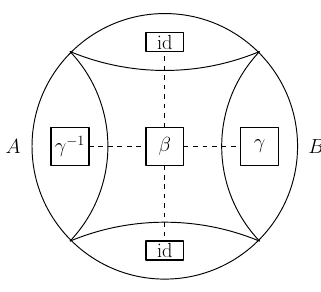
Figure 34 . Matching a fixed-area state with the corresponding tensor